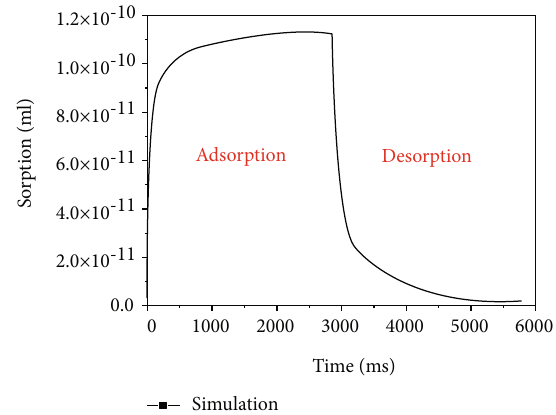
Figure 7: Variation of the gas sorption amount with time in numerical